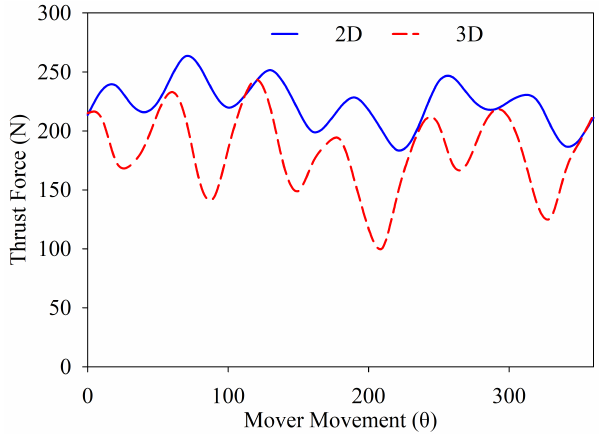
Figure 20. Thrust force of 3D and 2D single-sided